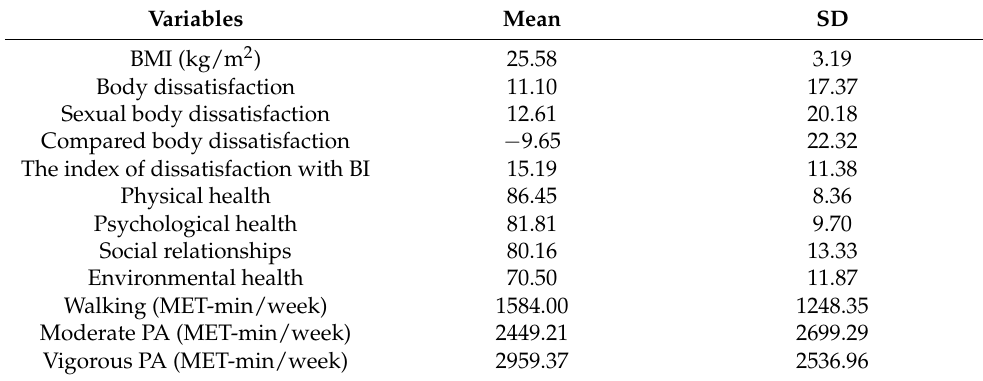
Table 1. Descriptive statistics ( n = 500).